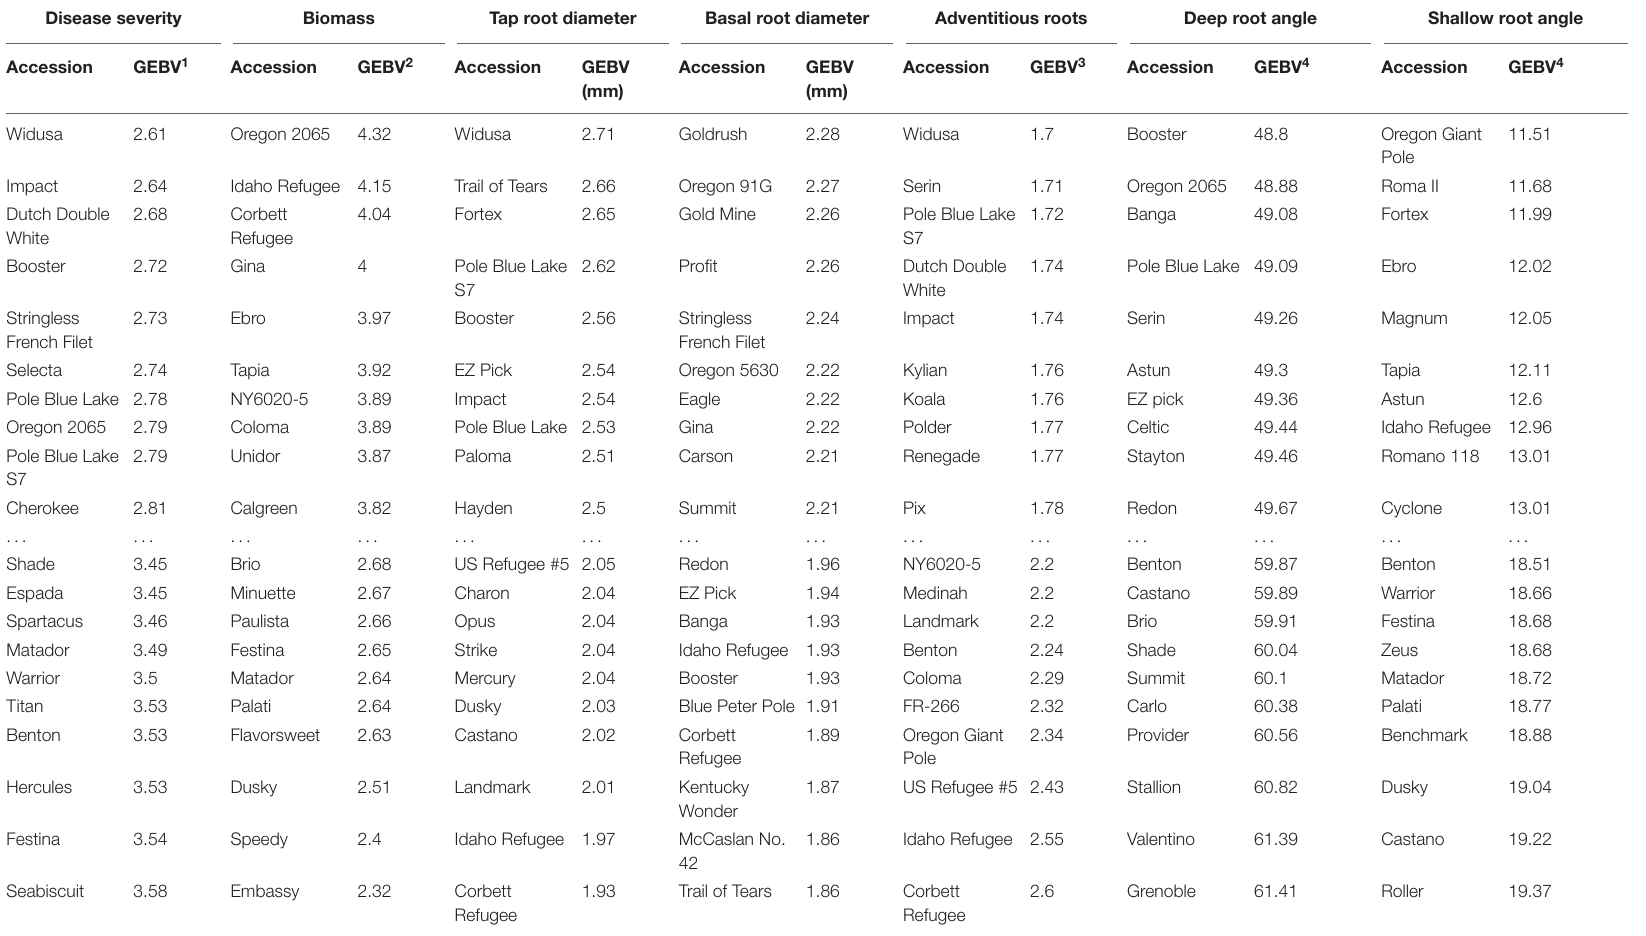
TABLE 7 | Genomic estimated breeding values (GEBV) calculated from BLUPs and BLUEs for the 10 highest and 10 lowest ranked lines in the BeanCAP Snap Bean Diversity Panel for Fusarium solani root rot disease severity, plant biomass, tap root, basal root diameter, adventitious roots, deepest and shallowest root